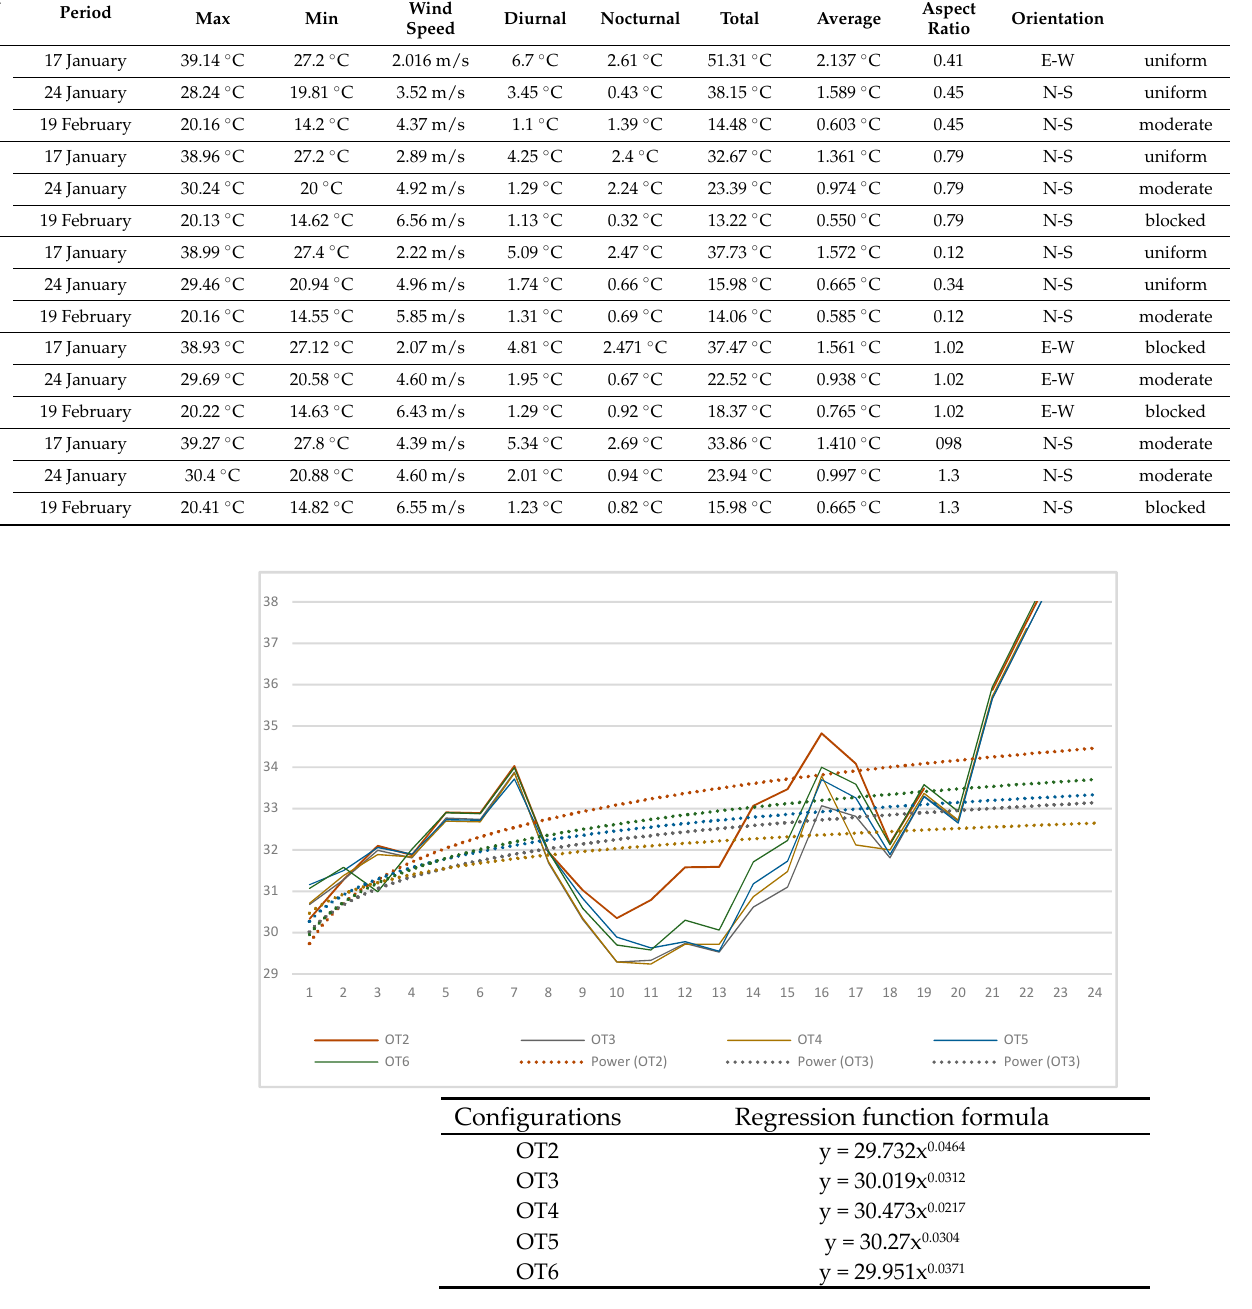
Figure 8. Summary of the maximum ambient air temperature values derived from the analysis of the heat map on 17th January in open types arrangements with their associated regression function formula.